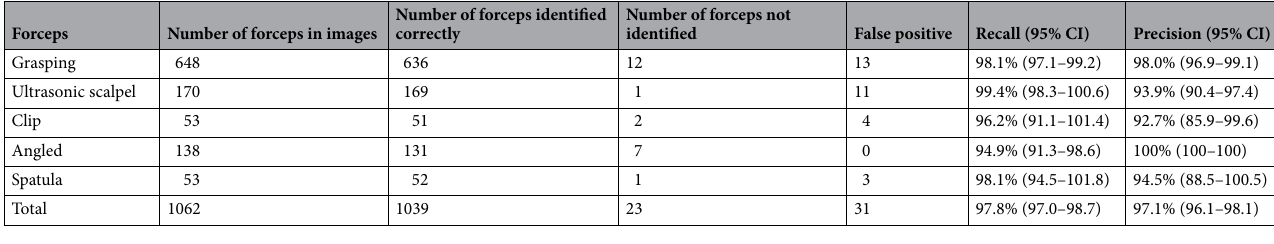
Table 2. Test results for each type of forceps, and corresponding recall and precision.